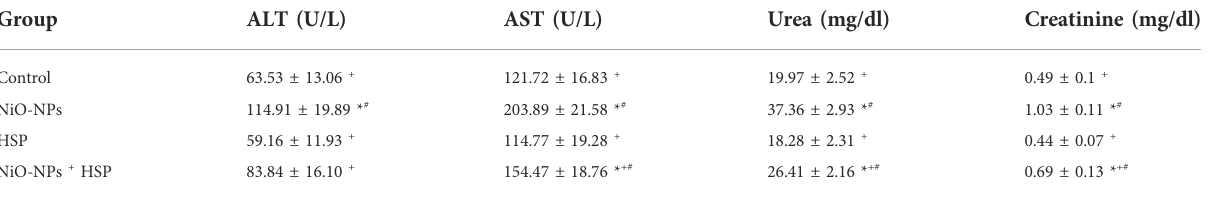
TABLE 2 Effects of NiO-NPs and/or HSP exposure on liver and kidney function parameters in the serum of rats. Group